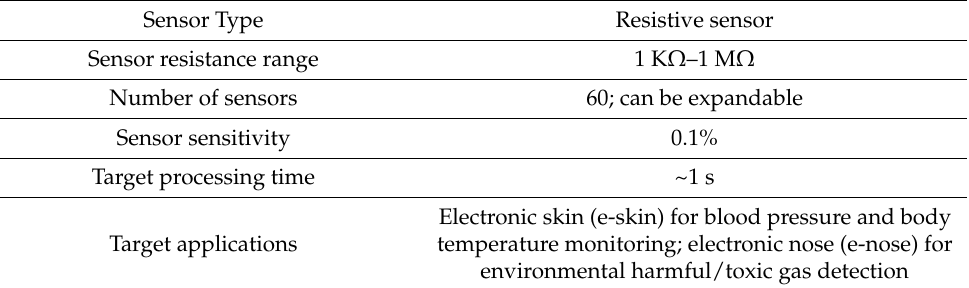
Figure 1. System-level block diagram, conceptually depicting readout electronics housed in a wristband chassis. Table 1. System specifications.